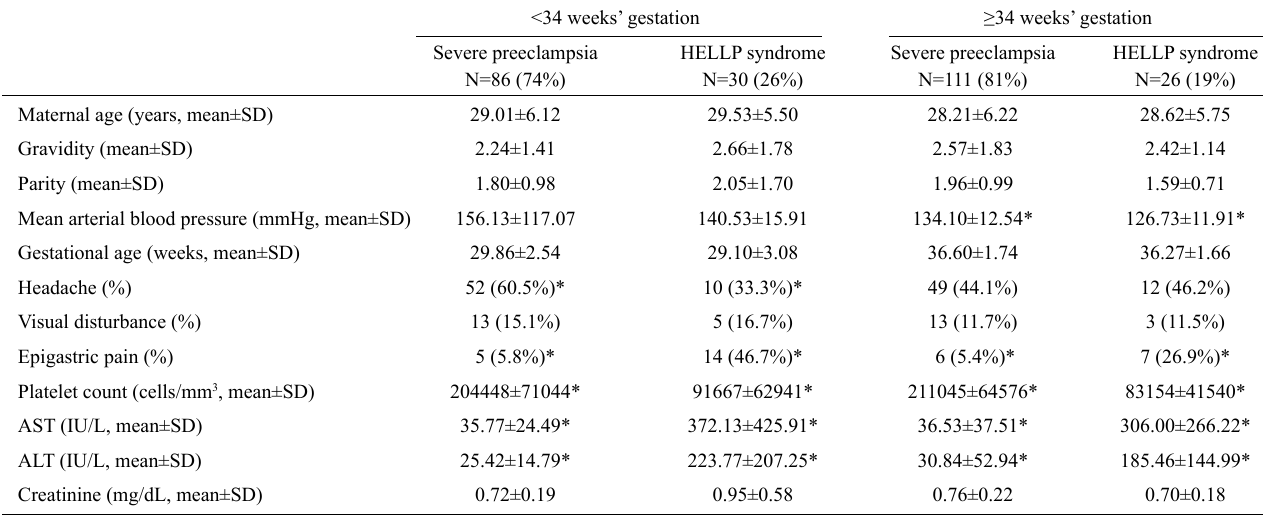
TABLE 1. Demographic characteristics, clinical and laboratory findings